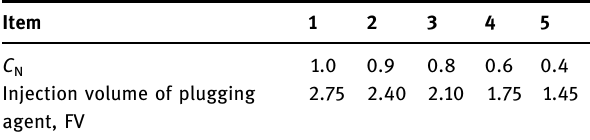
Table 3: Injection volume of gel solution at di ff erent leak o ff degrees of cross - linking agent